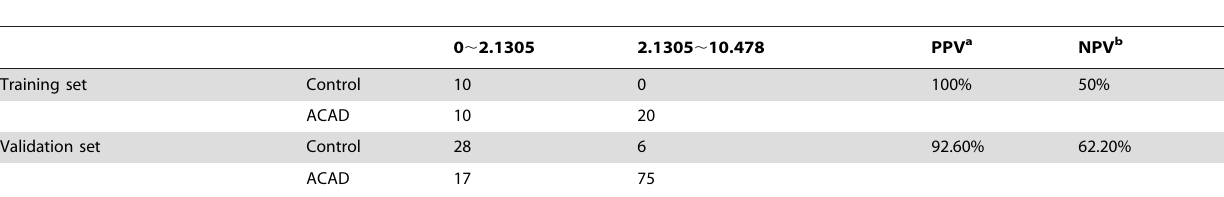
Table 3. Risk score analysis of ACAD cases and control